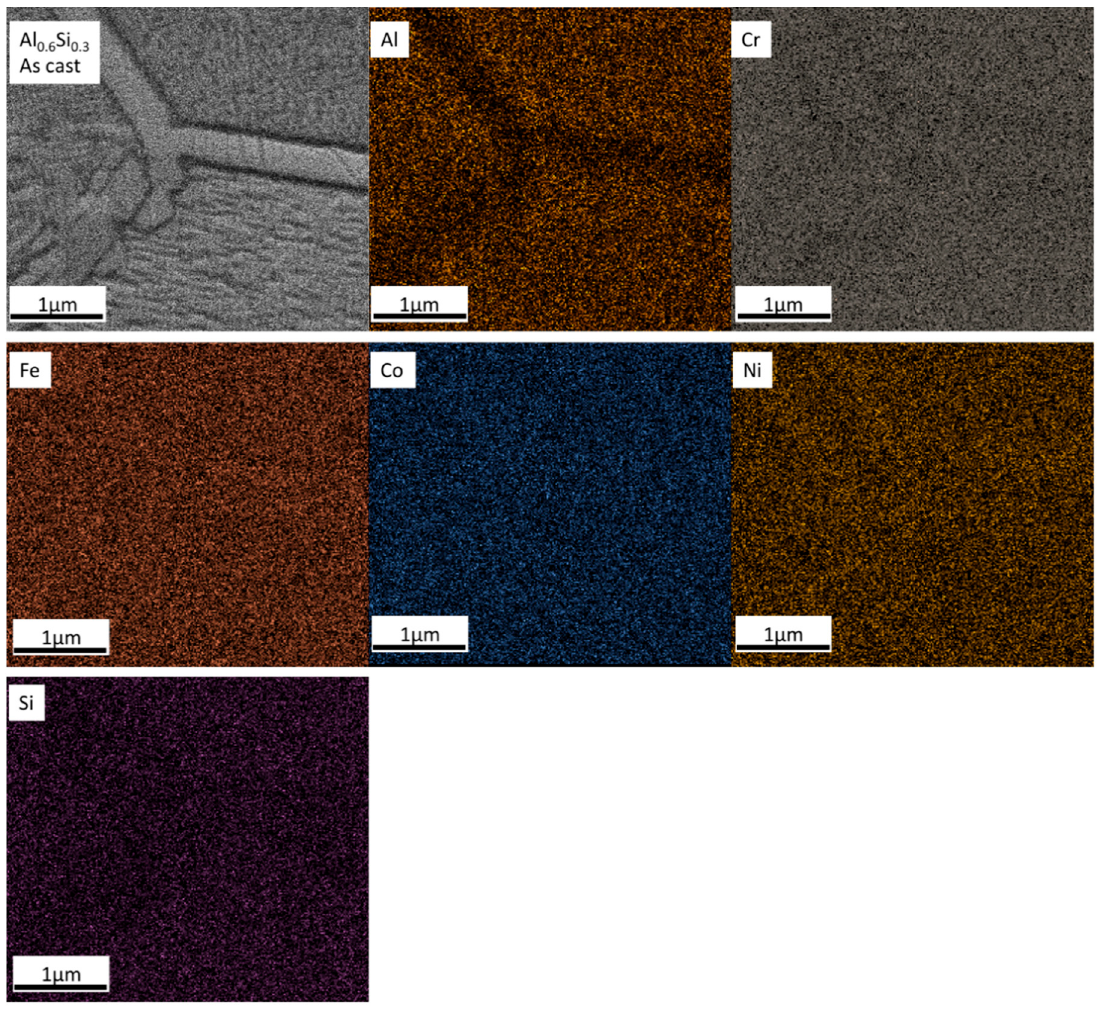
Figure 3. BSE SEM-micrograph and the corresponding EDS-mapping results of Al 0.6 Si 0.3 in its as-cast state.